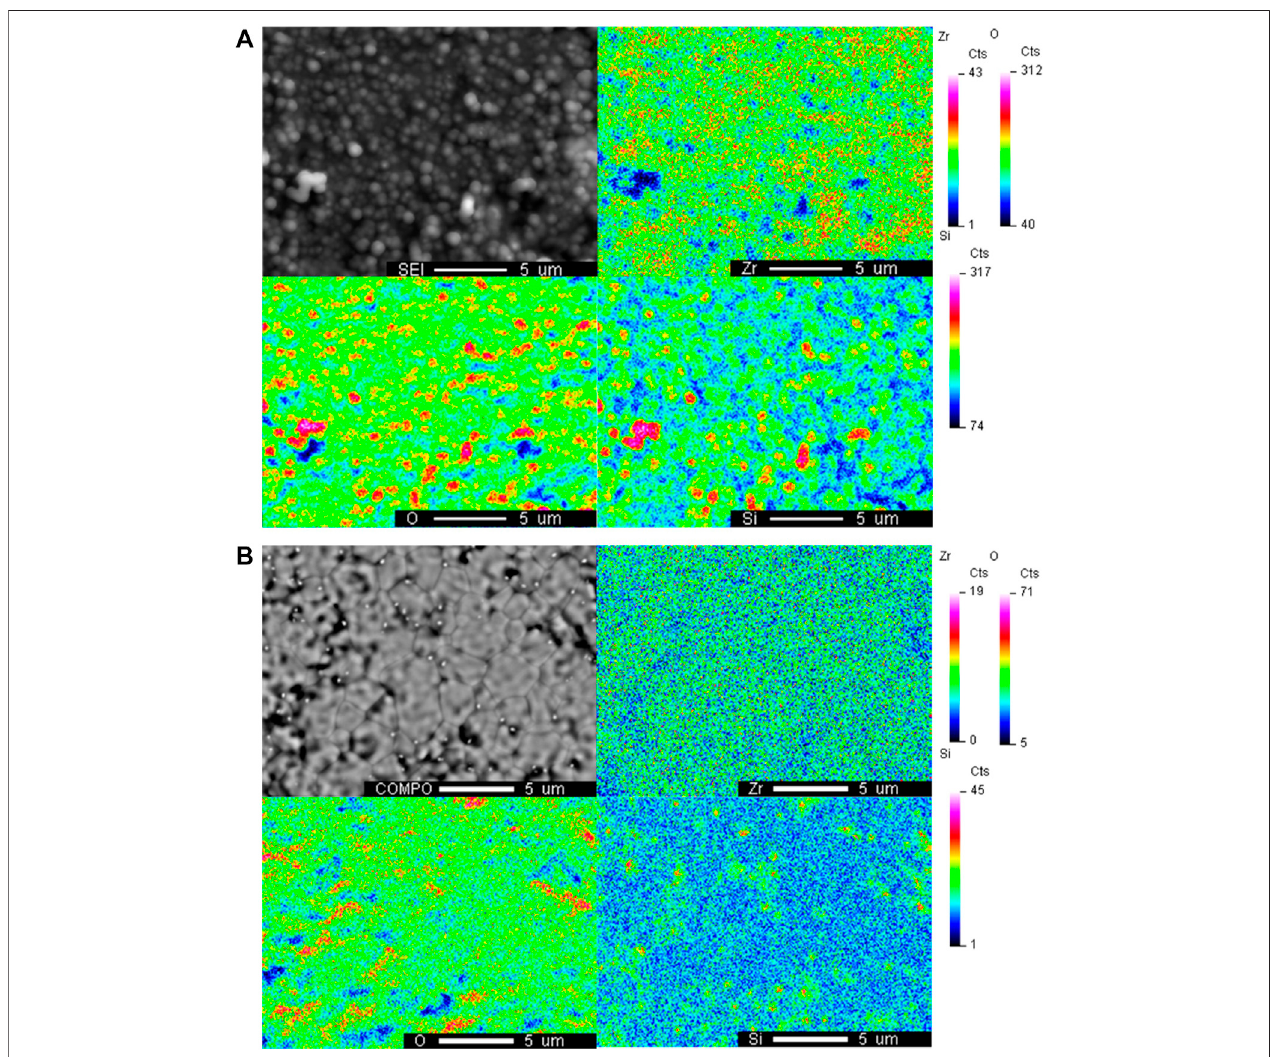
FIGURE6| WDSelementalmappingofthesurfaceofYSZpelletwithH 2 +H 2 O+N 2 +siloxanecomtaminationafter (A) D4contaminationand (B) L4contaminationat 750 ° C.